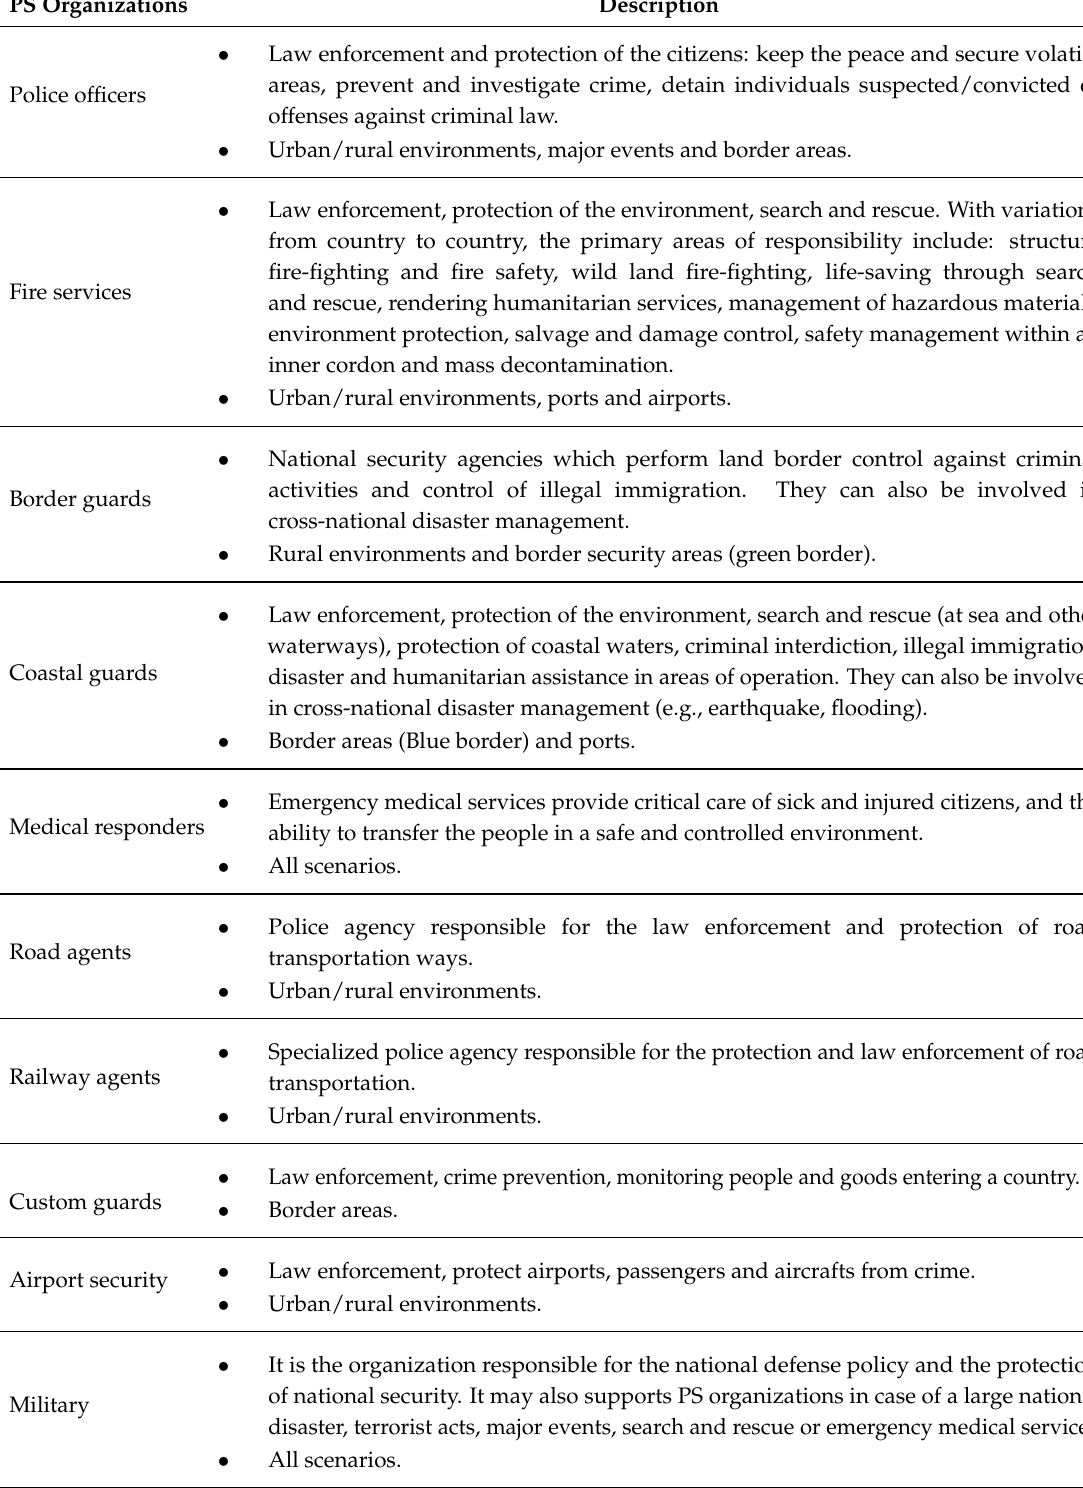
Table 1. Public Safety (PS)